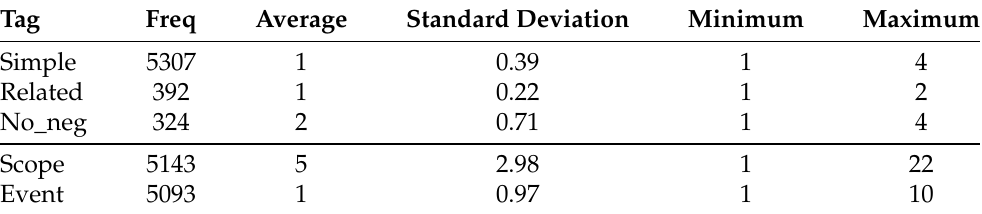
Table 4. Frequency distribution by negation tags. Right-side data are expressed in number of words per tag.